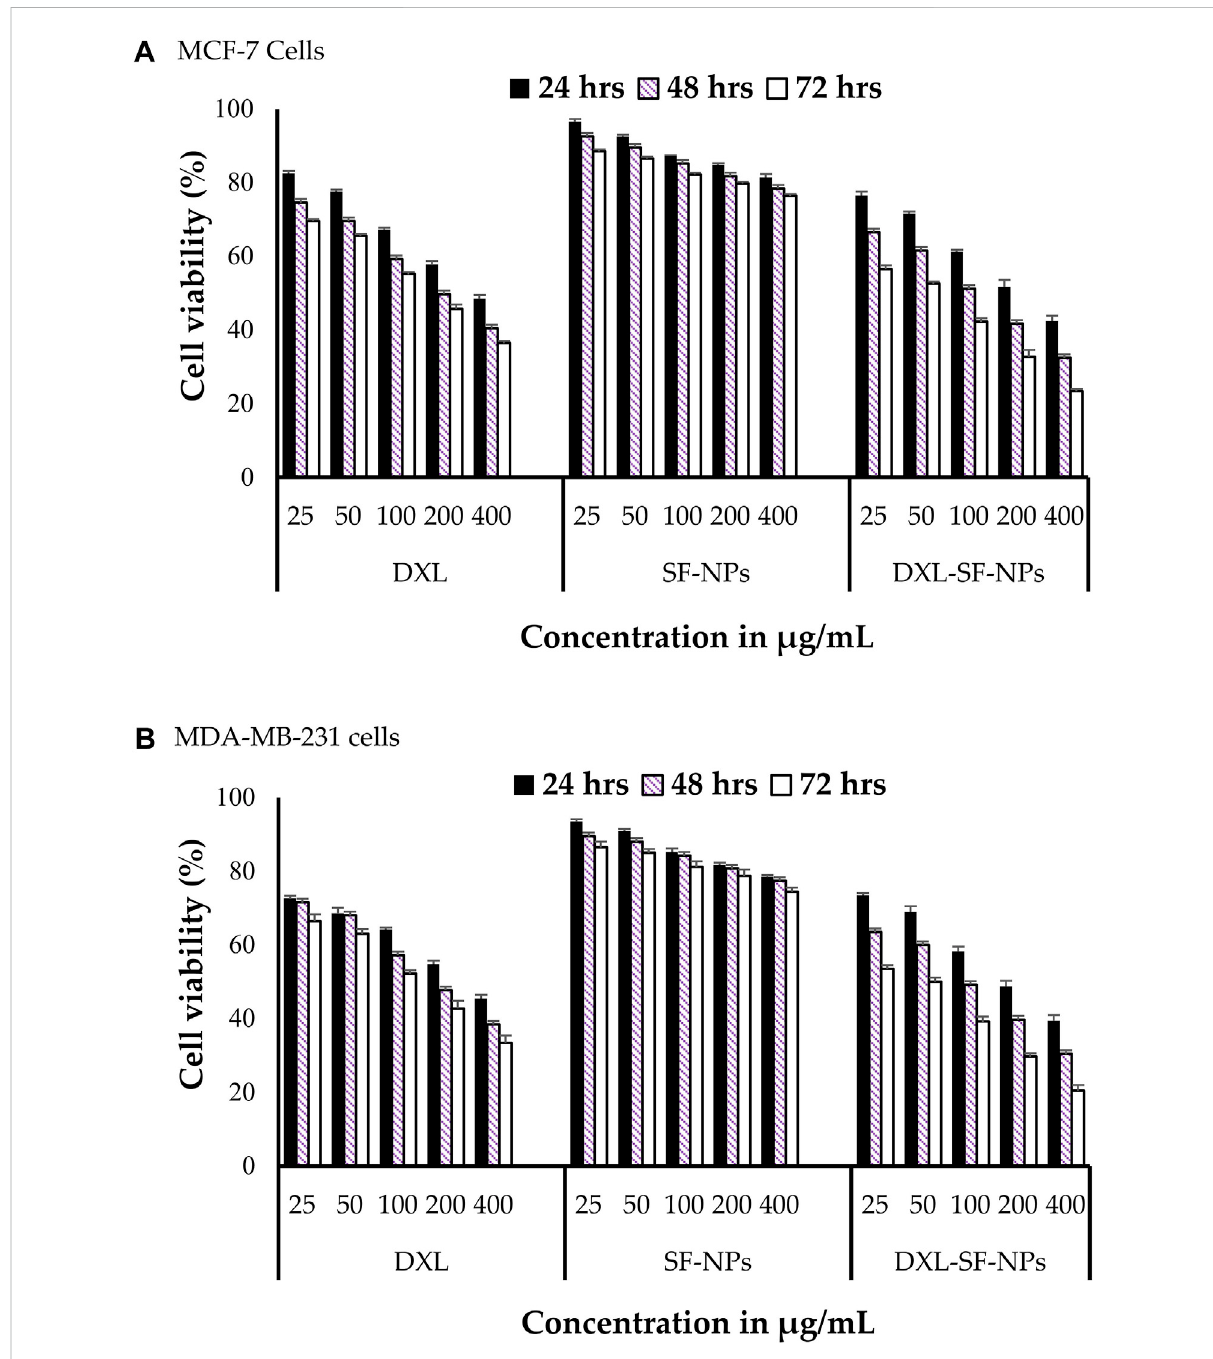
FIGURE 2 In vitro cytotoxicity of DXL-loaded SF-NPs against breast cancer cell lines. (A) MCF-7 and (B) MDAMB-231 cells were incubated with different concentrations of free DXL, SF-NPs, or DXL-loaded SF-NPs for different incubation times Notes: Al Saqr, A., Wani, S.U.D., Gangadharappa, H.V., Aldawsari, M.F., Khafagy, E.S., Lila, A.S.A., 2021. Enhanced cytotoxic activity of docetaxel-loaded silk fi broin nanoparticles against breast cancer cells. Polymers 13: 1416. Reprinted with permission from references. Copyright 2021,